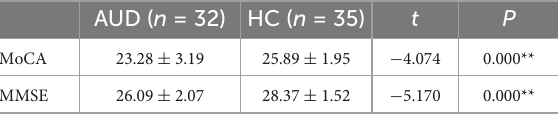
TABLE 1 Demographic data and alcohol consumption of participants. TABLE 2 Comparison of MoCA and MMSE scores